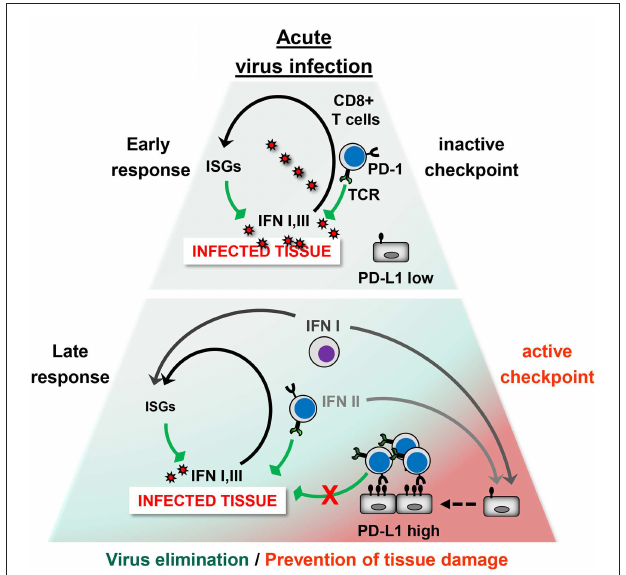
FIGURE 2 | The PD-1/PD-L1 checkpoint in acute virus infection. Early phase: The infected tissue produces type I IFNs and possibly type III IFNs, which strongly induce antiviral IFN - stimulated genes (ISGs) but only moderate PD-L1 levels. Antiviral CD8 + T cells eliminate virus-infected cells. At this stage, the PD-1/PD-L1 checkpoint activity is low and does not restrict the antiviral immune response. Late Phase: Type II IFN and TNF- α is secreted by CD8 + T cells and other immune cells. In addition, hematopoietic cells such as plasmacytoid DCs (pDCs) produce large amounts of type I IFN. This results not only in virus elimination but also increases PD-L1 expression. The high checkpoint activity downregulates terminal differentiation of antiviral CD8 + T cells. Ideally, the strength and quality of the CD8 + T cell response is balanced out in such a way that the viral intruder is eliminated without causing